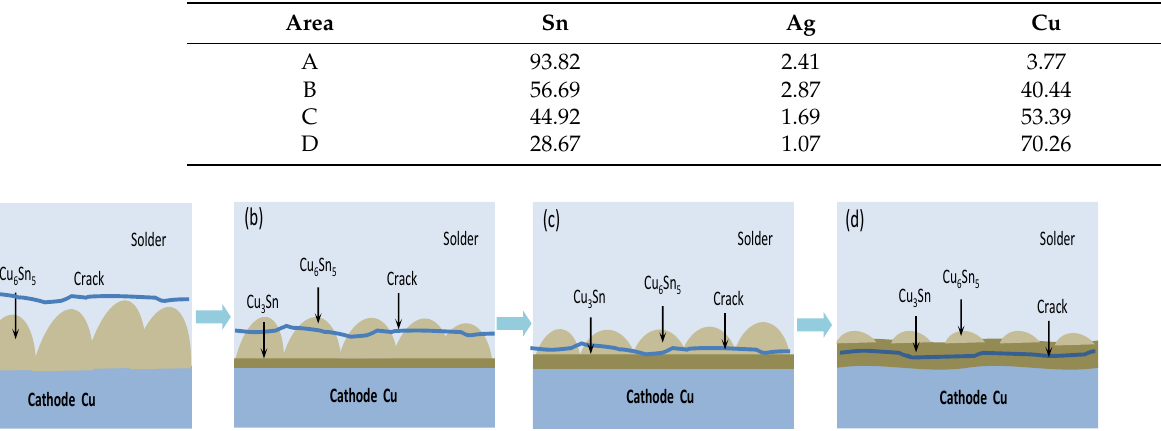
Figure 12. Shear fracture path of solder joints in four stages under current loading (j = 7 × 10 3 A/cm 2